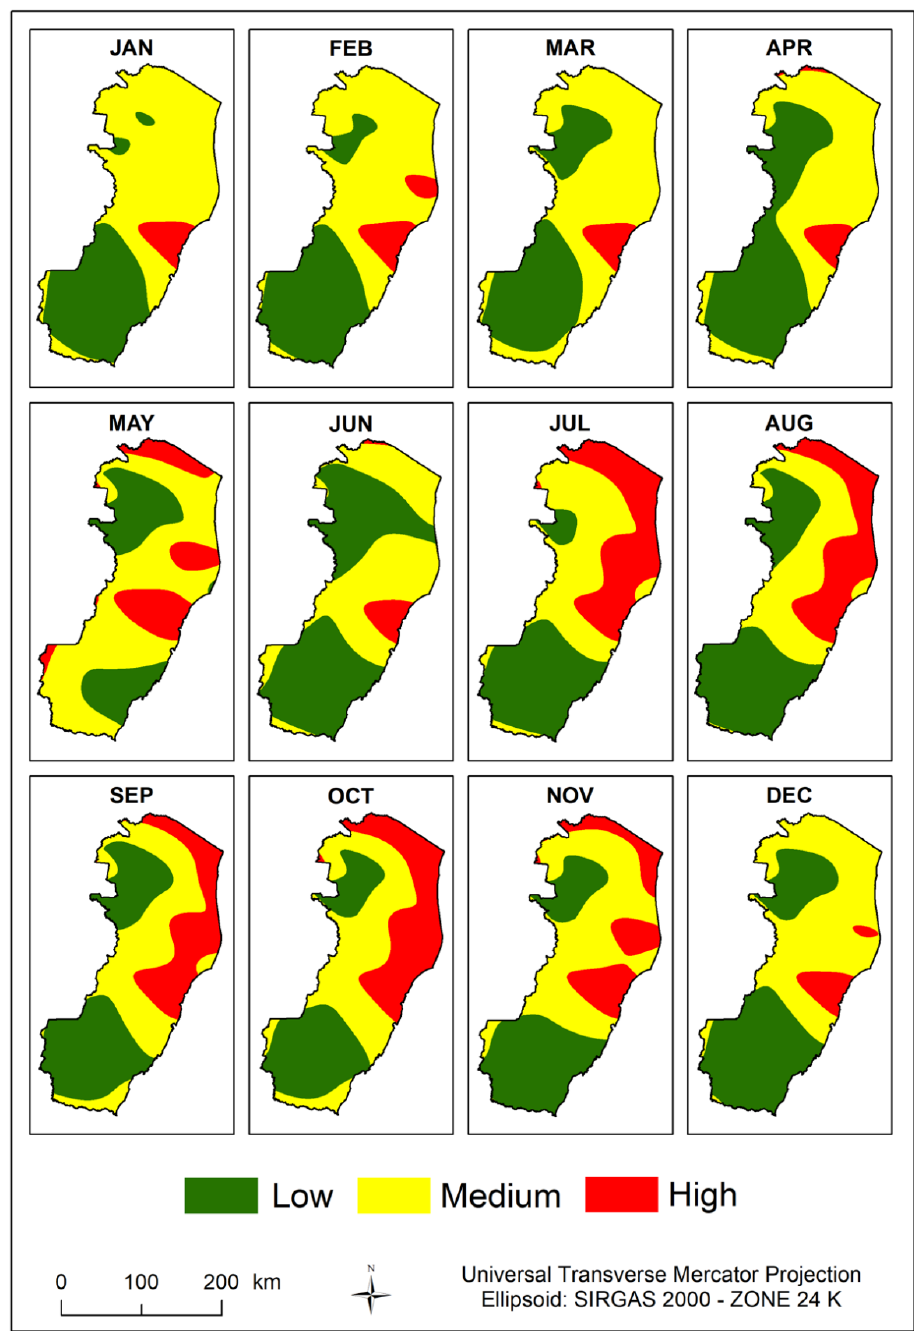
Figure 5. Spatiotemporal dynamics of the fuzzy risk index for eucalyptus rust ( Austropuccinia psidii ) in the state of Espírito Santo, Brazil, over the months from January to December (2006–2013).